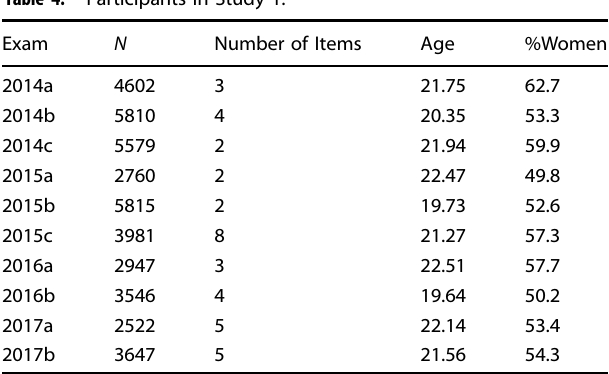
Table 4. Participants in Study